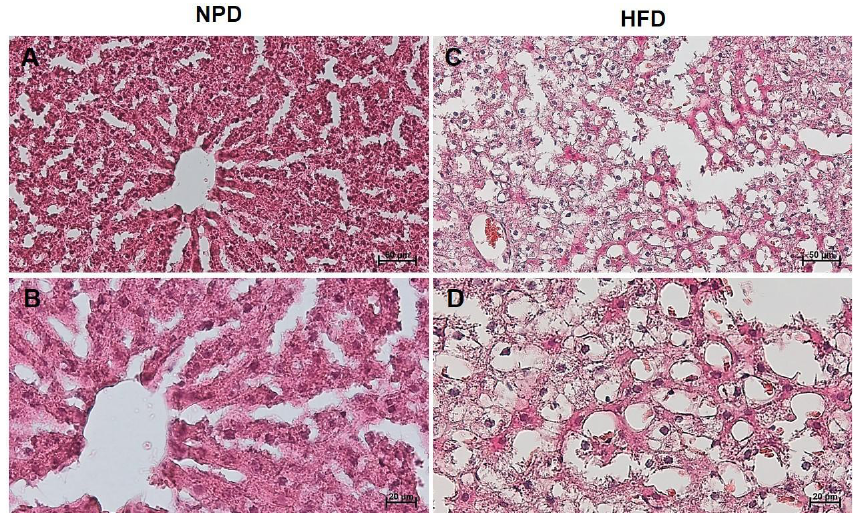
Figure 10. Histological features of liver tissue of NPD and HFD groups. Representative images of hematoxylin and eosin staining of liver tissue ( A , B : NPD; C , D : HFD). ( A , C ): magnification 200×, scale bar 50 µm. ( B , D ): magnification 400×, scale bar 20 µm.